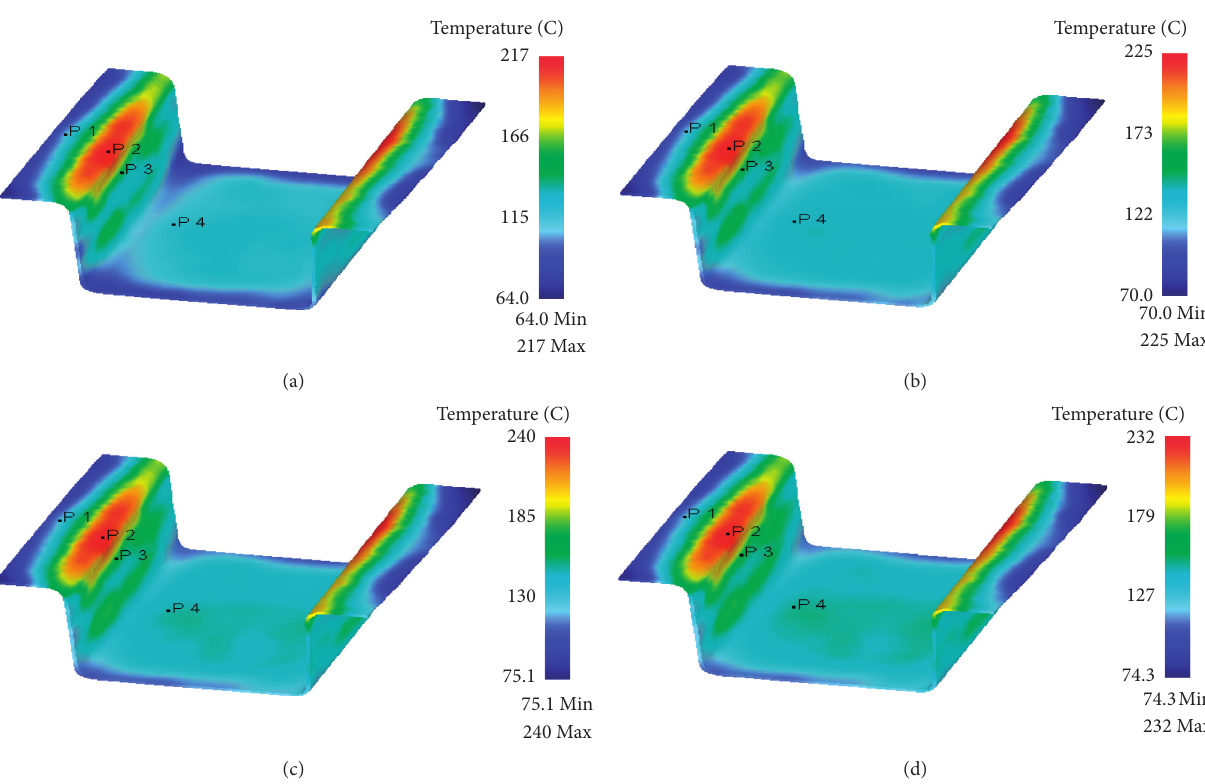
Figure 9: Temperature distribution of the formed part after the synchronous quenching process in quantity production: (a) the second formed part; (b) the fourth formed part; (c) the eighth formed part; (d) the tenth formed